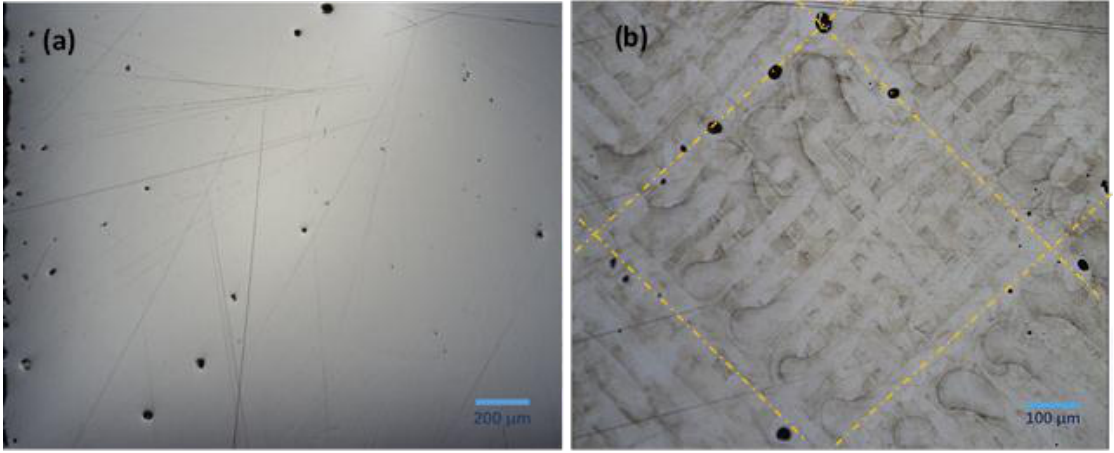
Figure 5. Micrographs showing porosity distribution for the ( a ) un-etched and ( b ) etched specimen cut along the x – y plane.